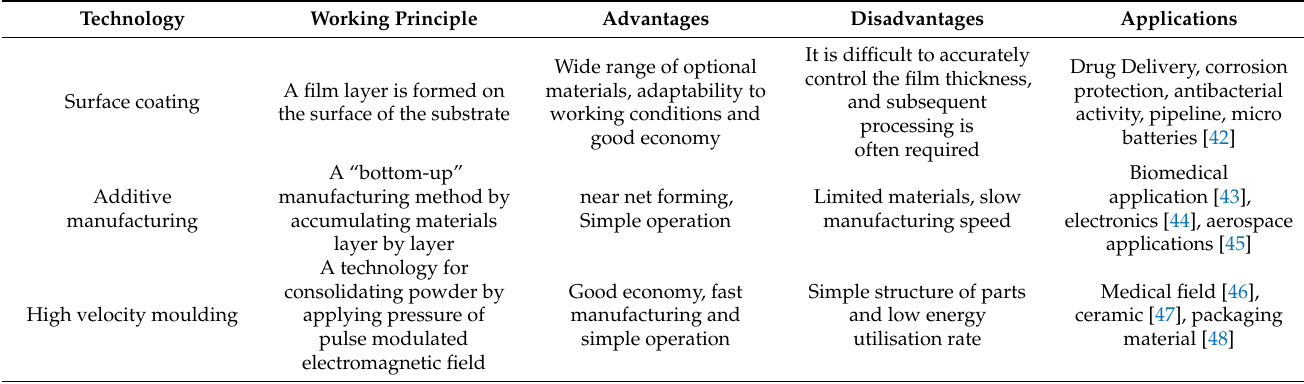
Table 3. Summary of established manufacturing